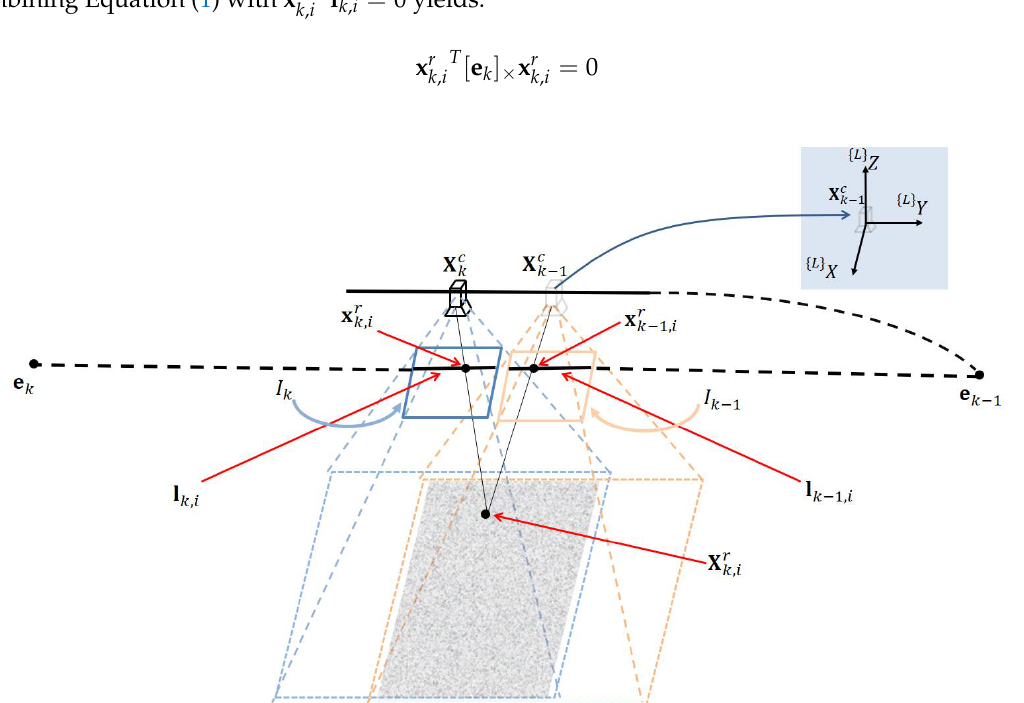
Figure 3. 3D road surface reconstruction from two